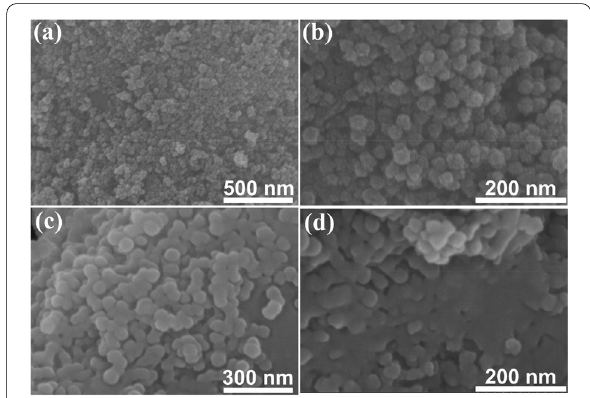
Fig. 2 Electron microscopy images of the as‑prepared materials in scanning mode. a , b FESEM images of the SnO 2 nanospheres and c , d reduced graphene oxide incorporated SnO 2 nanospheres nanocomposites at two different